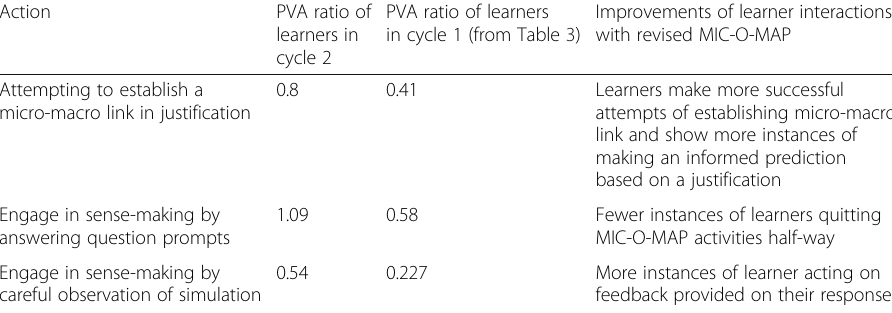
Table 6 Productive value action of students interacting with revised MIC-O-MAP